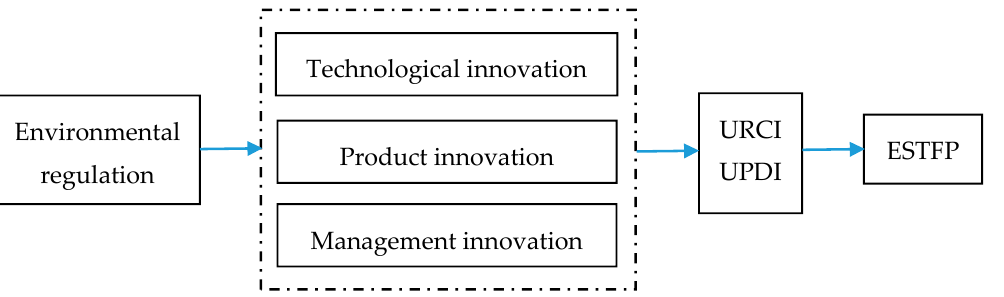
Figure 5. Channels of Environmental Regulations Affecting ESTFP.